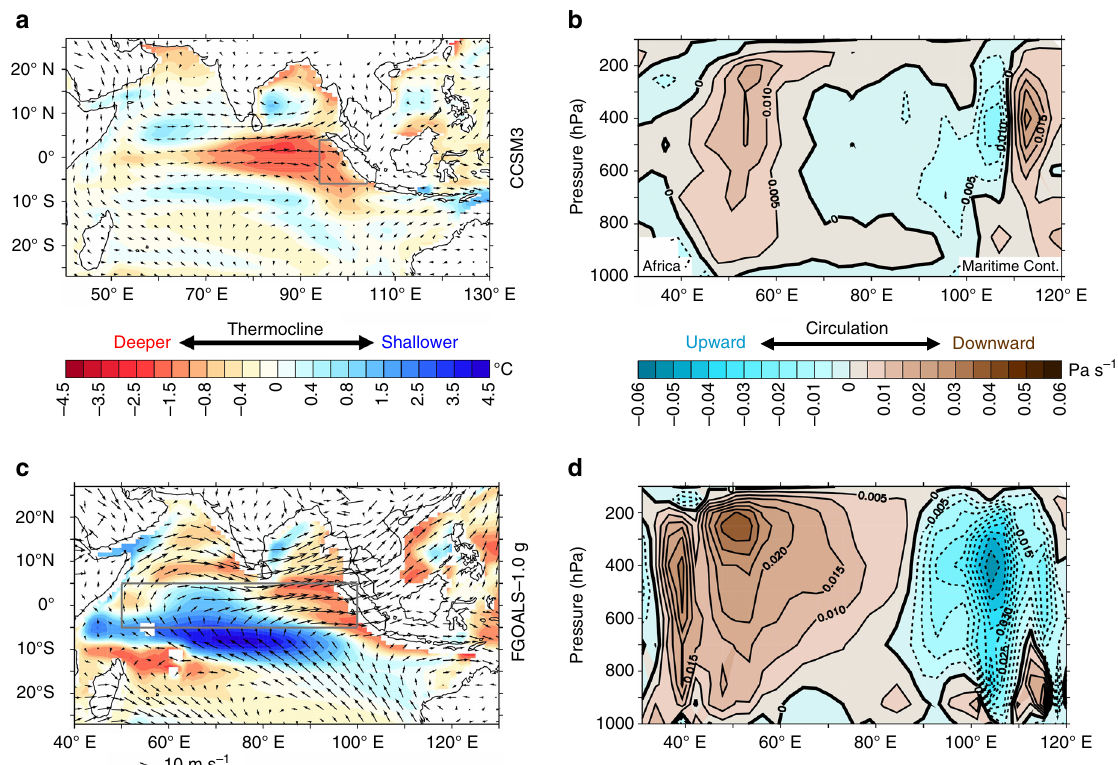
Fig. 5 LGM climate anomalies in the Indian Ocean region as simulated by CCSM3 and FGOALS-g1.0. Shown are LGM anomalies (annual mean) relative to pre-industrial control runs for Δ T (de fi ned as ocean temperature difference between surface and 70 m as a measure for tropical thermocline depth) and low-level (925 hPa) wind ( a , c ) and vertical velocity ( ω ) between 5° S and 5° N ( b , d ) for the two climate models with greatest LGM thermocline deepening in the eastern equatorial Indian Ocean and strongest equatorial westerly wind anomalies (Nos. 13 and 14 in Fig. 4), CCSM3 ( a , b ) and FGOALS- g1.0 ( c , d ). Grey box in a shows the region for calculating area-averaged Δ T in all the models in Fig. 4, while the grey box in c shows the region for averaging U eq . Modern coastlines are drawn in a and c for better